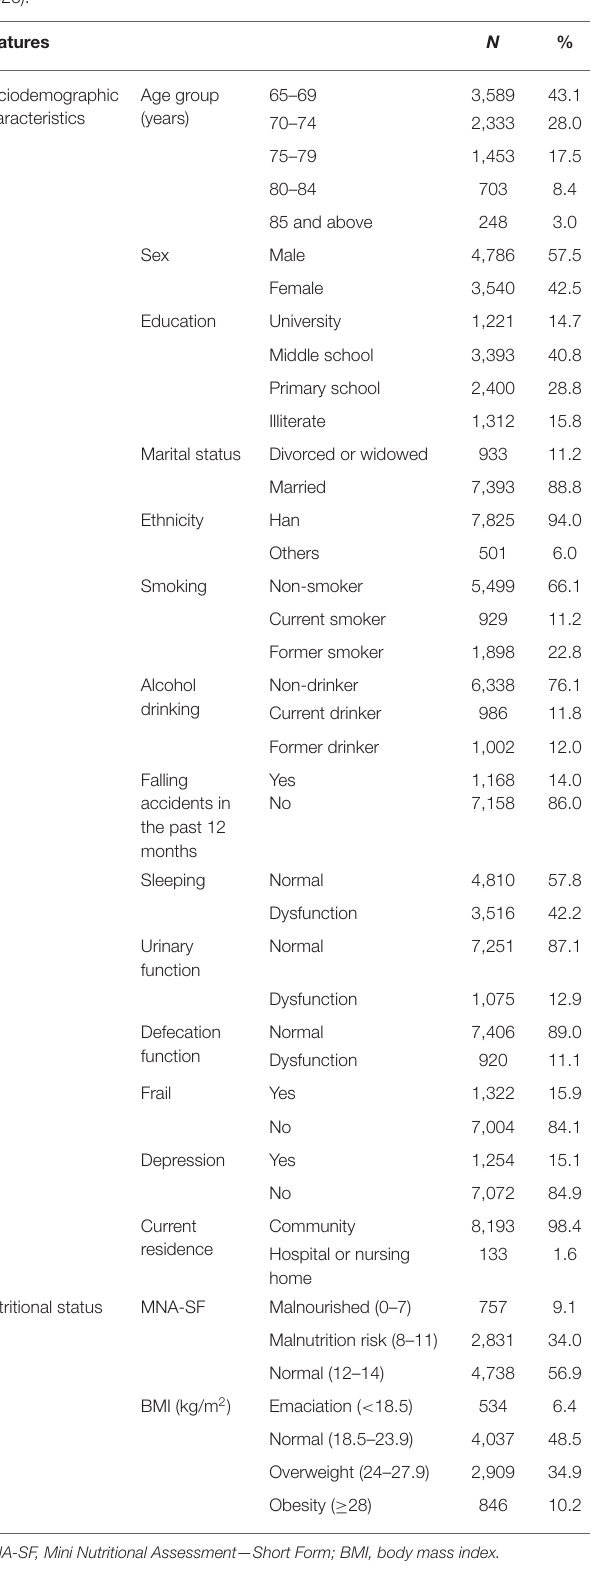
MNA-SF, Mini Nutritional Assessment—Short Form; BMI, body mass